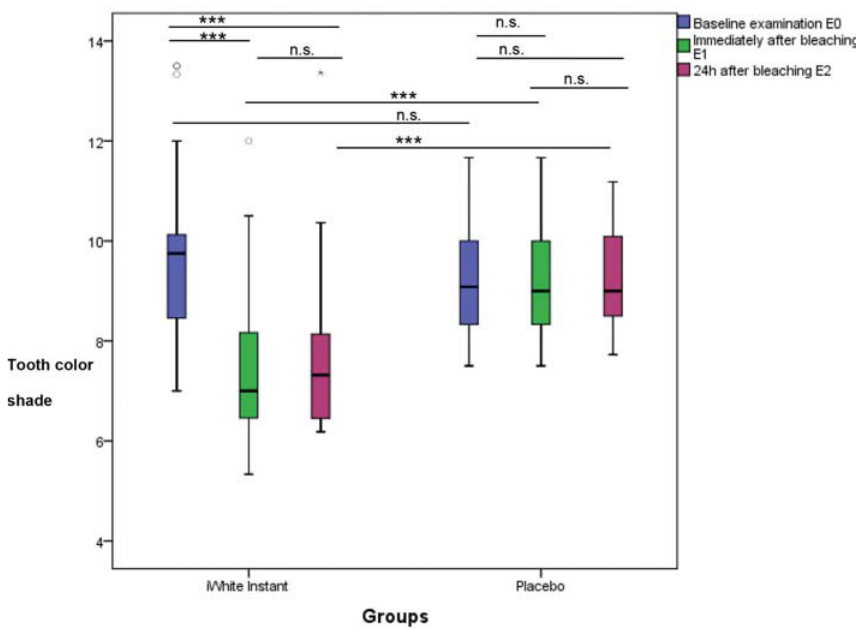
Figure 3- Values of the tooth color of the bleaching product and the placebo for baseline examination, immediately and 24 h after (cid:69)(cid:79)(cid:72)(cid:68)(cid:70)(cid:75)(cid:76)(cid:81)(cid:74)(cid:30)(cid:3)(cid:81)(cid:17)(cid:86)(cid:17)(cid:3)(cid:11)(cid:81)(cid:82)(cid:87)(cid:3)(cid:86)(cid:76)(cid:74)(cid:81)(cid:76)(cid:191)(cid:70)(cid:68)(cid:81)(cid:87)(cid:12)(cid:30)(cid:3)(cid:13)(cid:13)(cid:13)(cid:3)(cid:11)(cid:83)(cid:31)(cid:19)(cid:17)(cid:19)(cid:19)(cid:20)(cid:12)